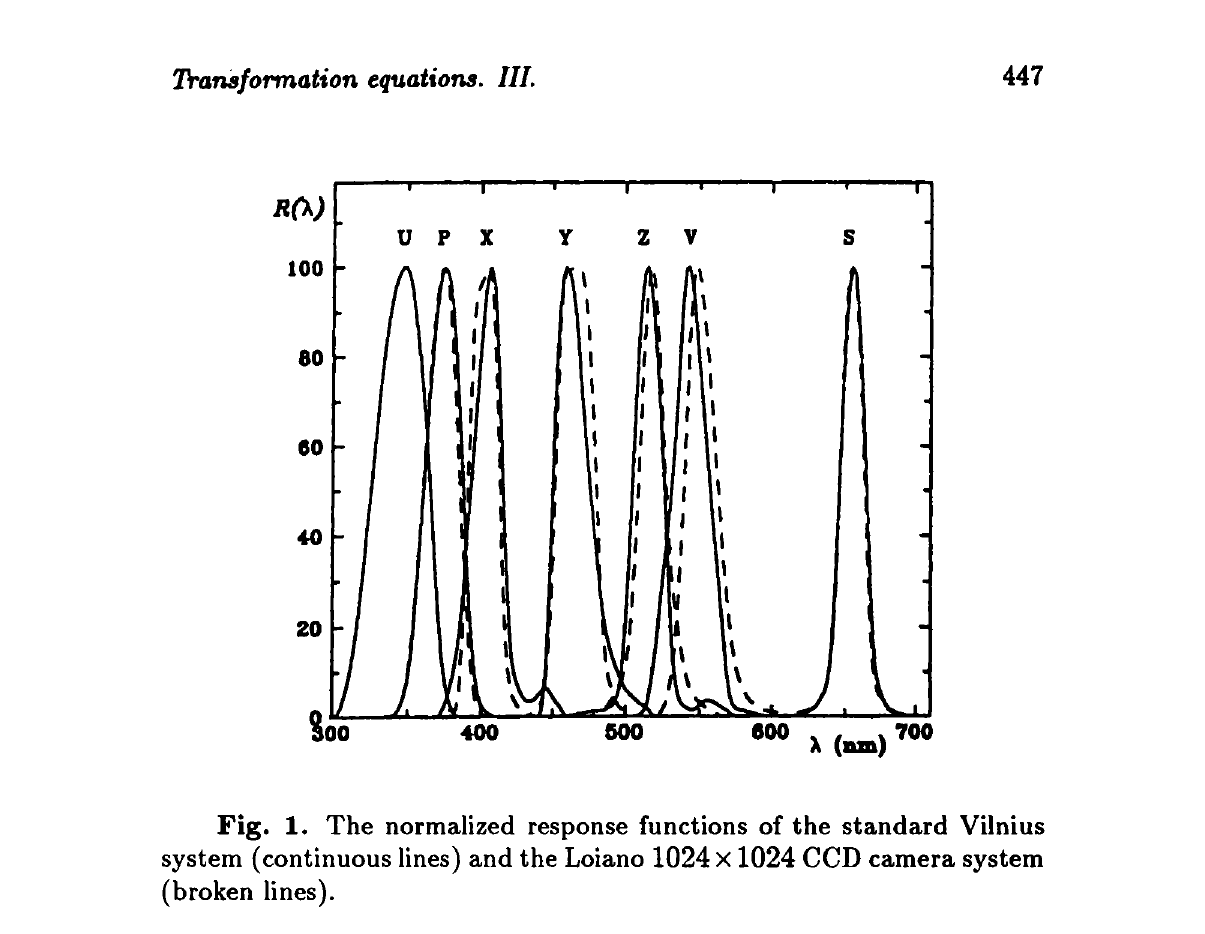
Fig. 1. The normalized response functions of the standard Vilnius system (continuous lines) and the Loiano 1024 X 1024 CCD camera system (broken